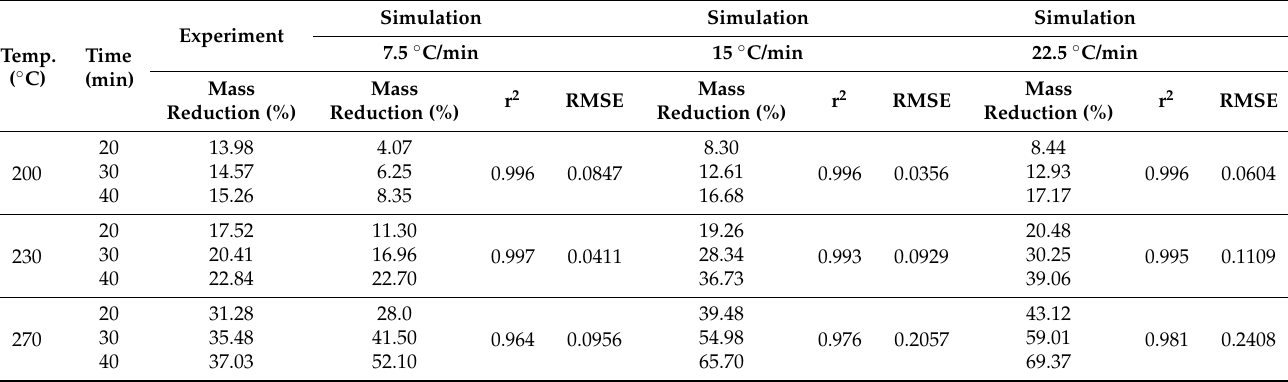
Table 7. Grape mass reduction comparison.